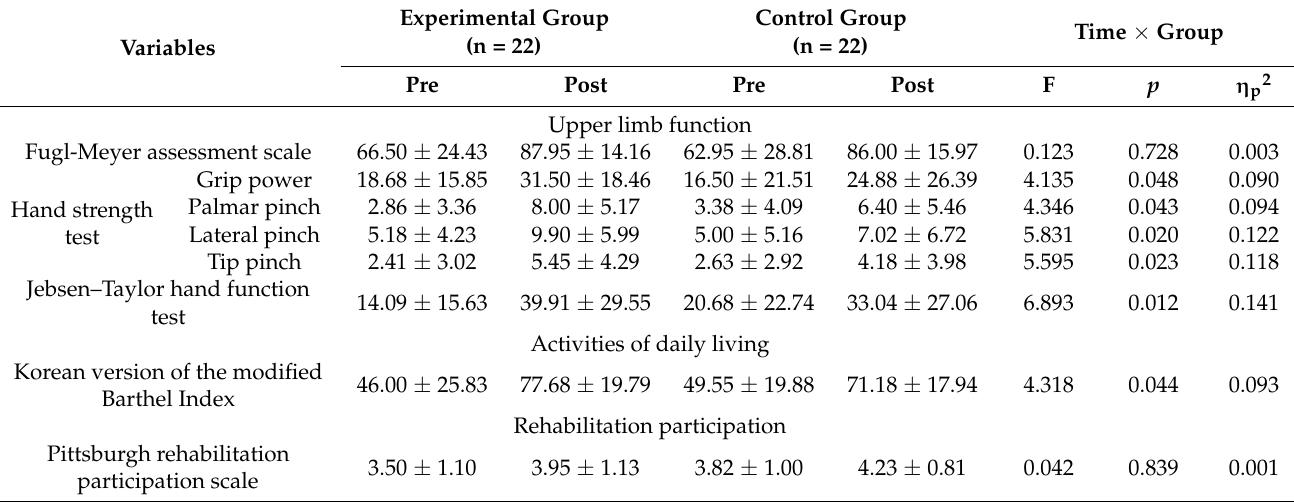
Table 2. Baseline and post-intervention in upper limb function, the performance of activities of daily living, and rehabilitation participation before and after training (N =